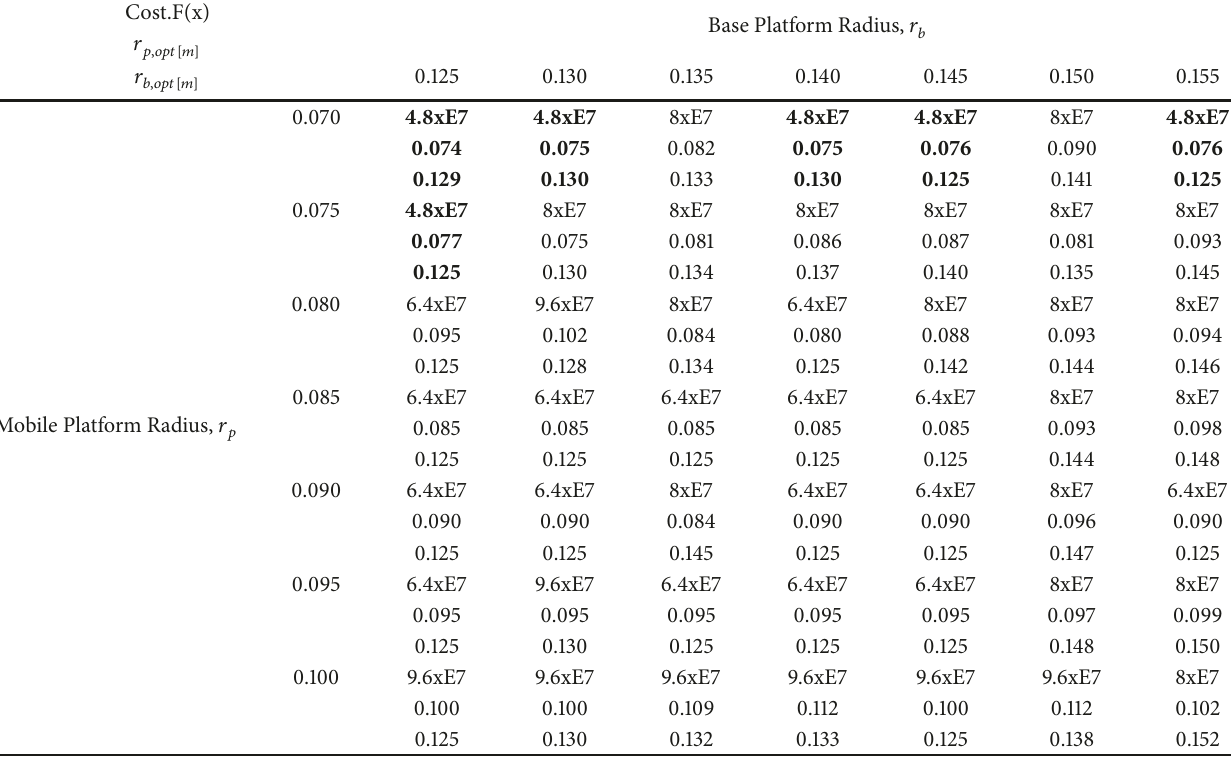
Table 2: Optimizing mobile platform diameter, 𝑟 𝑝 .